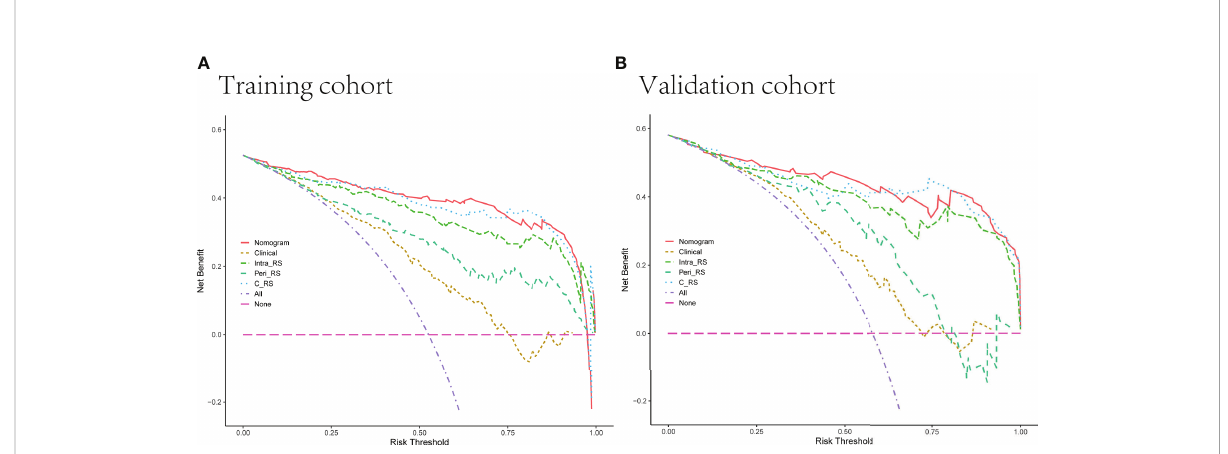
FIGURE 9 (A, B) Decision curves of 5 models in the training and validation sets. The net income is shown on the y-axis, and the probability threshold is shown on the